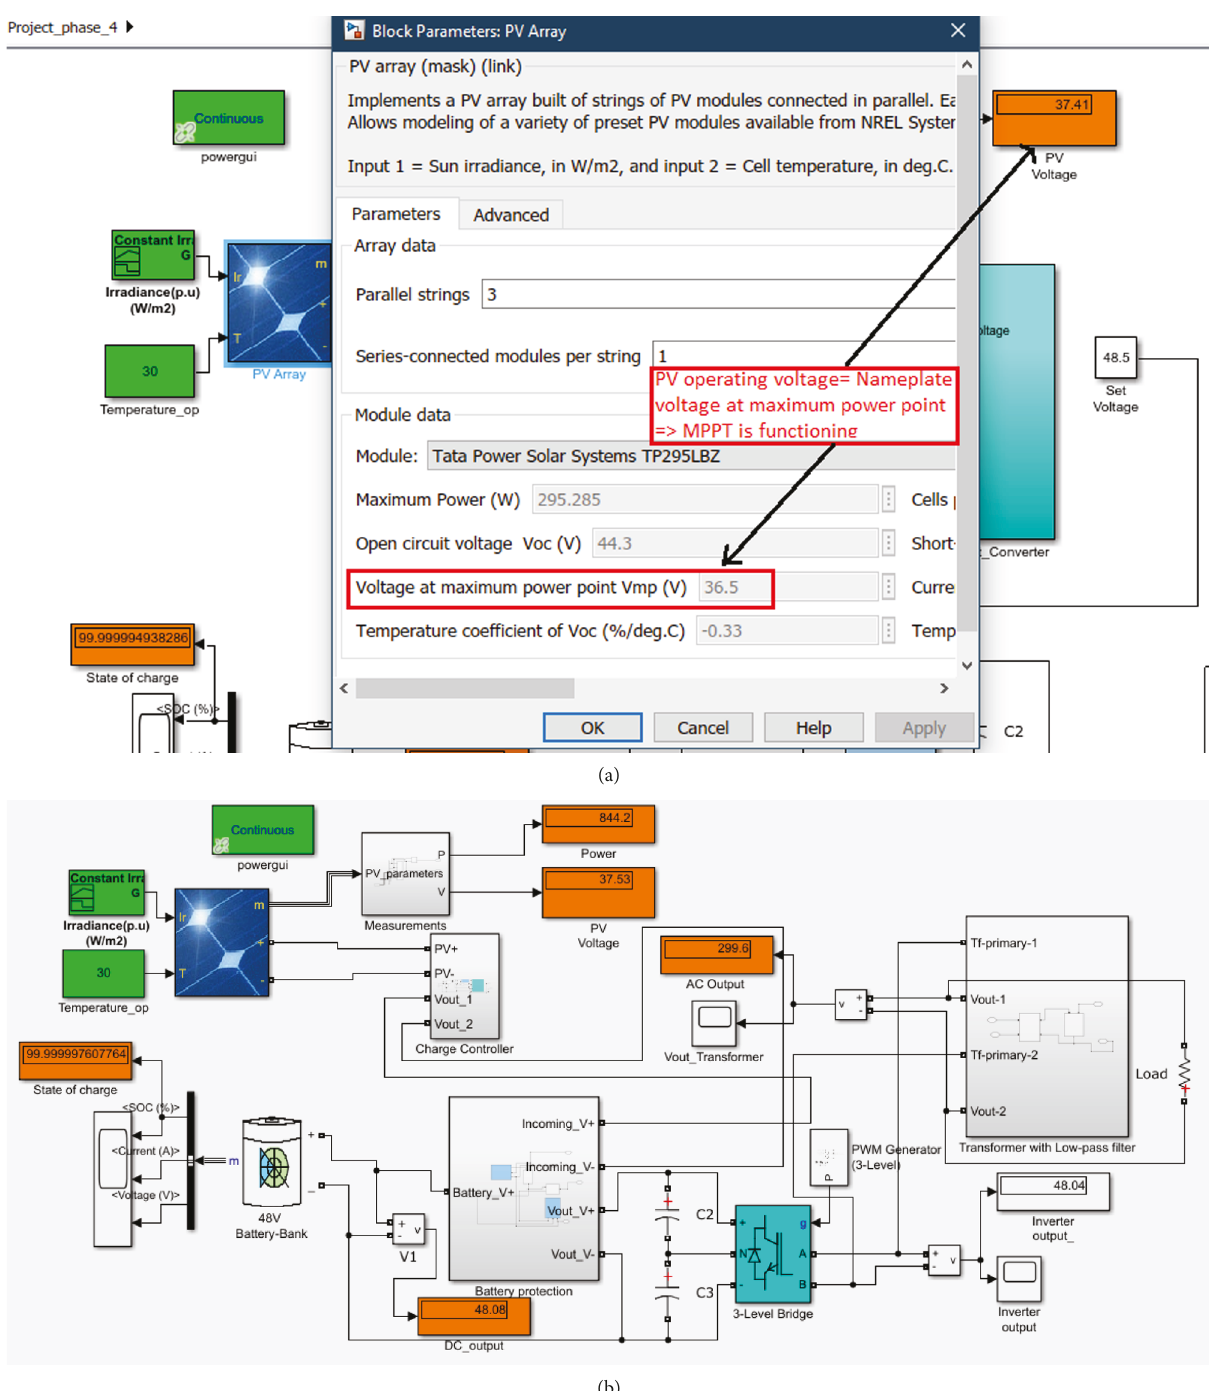
Figure 7: (a) Output voltage of PV when the system is operating at maximum power point (MPP) under MPPT. (b) Simulink simulations for the complete